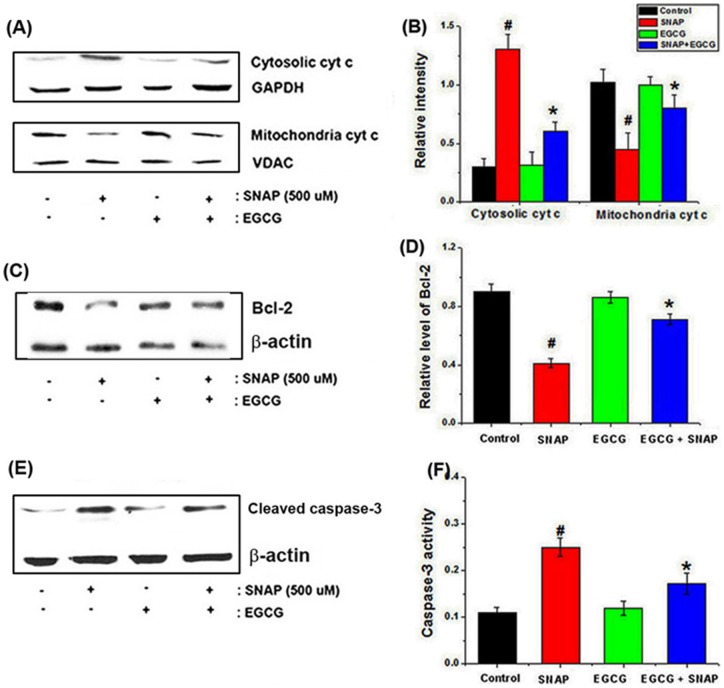
Effects of EGCG on NO-induced apoptosis-related genes in HEI-COΙ cells.(A) Cells were pretreated with 50 μM EGCG, followed by treatment with 500 μM SNAP for 24 h. After isolation of cytosolic and mitochondrial fractions, the protein extracts were assayed for cyt c by western blot analysis. GAPDH was used as an internal cytosolic marker control, and VDAC was used as a mitochondrial marker. (B) The relative levels of cytosolic and mitochondrial cyt c were quantified by densitometry. (C) Western blot analysis revealed a reduction in Bcl-2 protein after SNAP exposure. (D) Relative levels of Bcl-2 are shown. (E) The levels of cleaved caspase-3 after treatment with EGCG were assayed by western blot analysis. (F) The effect of EGCG on caspase-3 activation was determined using a colorimetric kit. All data represent the mean ± SEM of 3 independent experiments (#P<0.05 vs. control, *P<0.05 vs. SNAP alone).